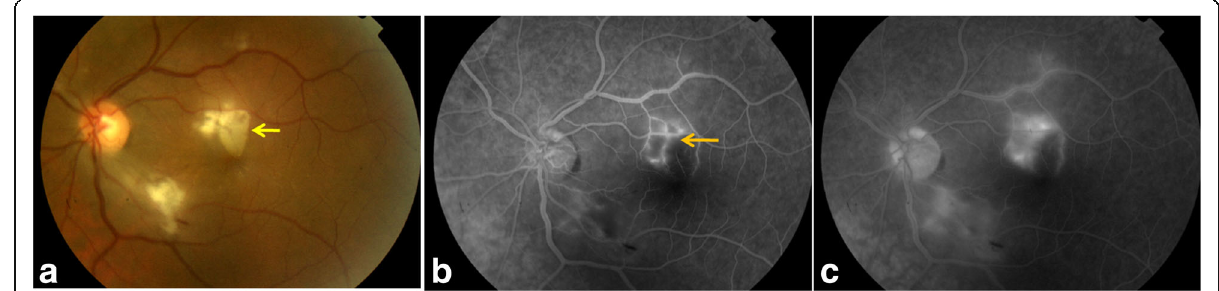
Fig. 2 A 38-year-old male patient presented with acute scotoma in the left eye. Color fundus photograph shows three retinal infiltrates with a triangle-shaped area of retinal ischemic whitening adjacent to a retinal infiltrate (arrow) ( a ). Fluorescein angiography confirms the presence of branch retinal artery occlusion corresponding to the area of retinal ischemic whitening (arrow). It also shows early hypofluorescence of the larger infiltrates and isofluorescence of the smaller infiltrate ( b ) and late staining of all three retinal infiltrates, retinal vascular leakage, and optic disc hyperfluorescence ( c ). Laboratory testing was positive for Mediterranean spotted fever ( Rickettsia Conorii